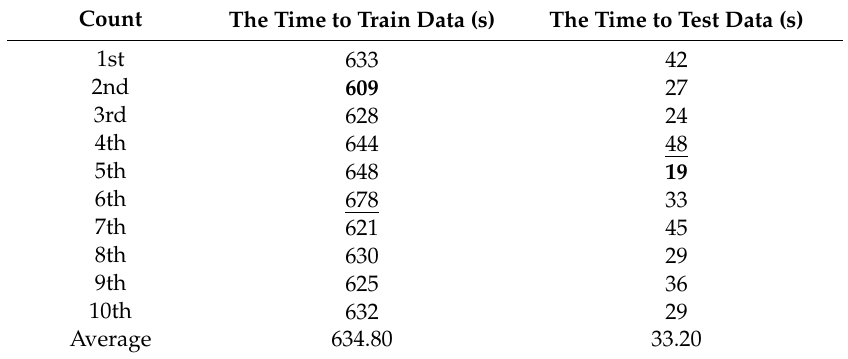
Table 5. Time for generating synthetic vessel images (The minimum value in each column is presented in bold, and the maximum value in each column is underlined). Count The Time to Train Data (s) The Time to Test Data